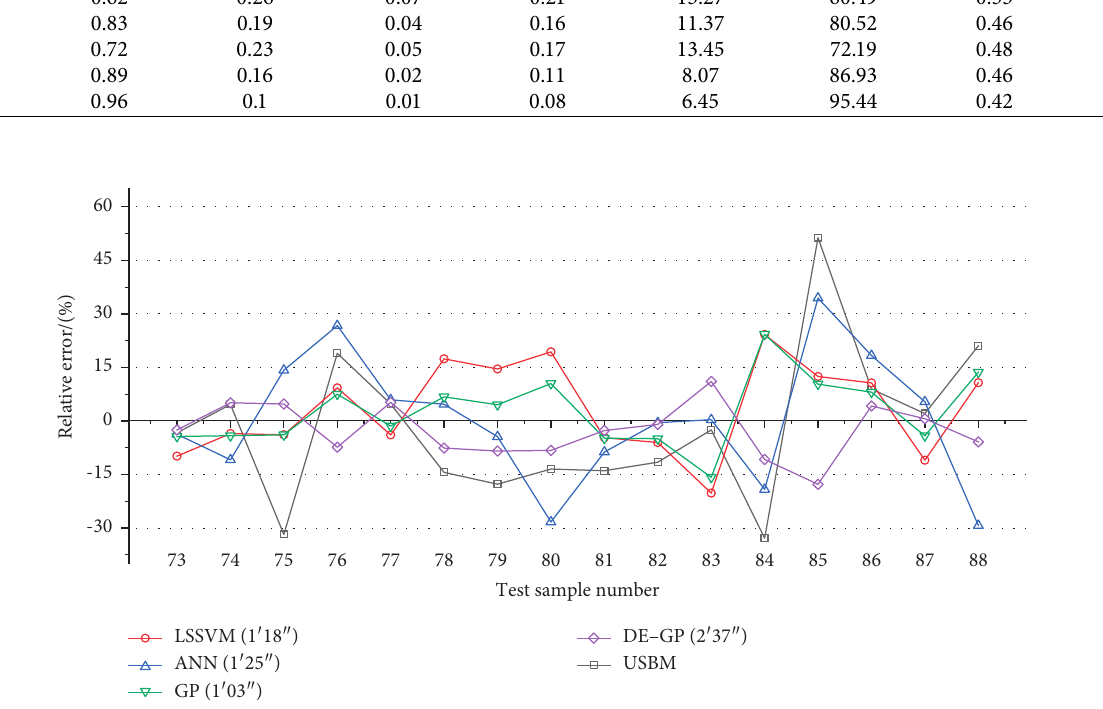
Figure 13: The relative error and calculation time of different PPV prediction